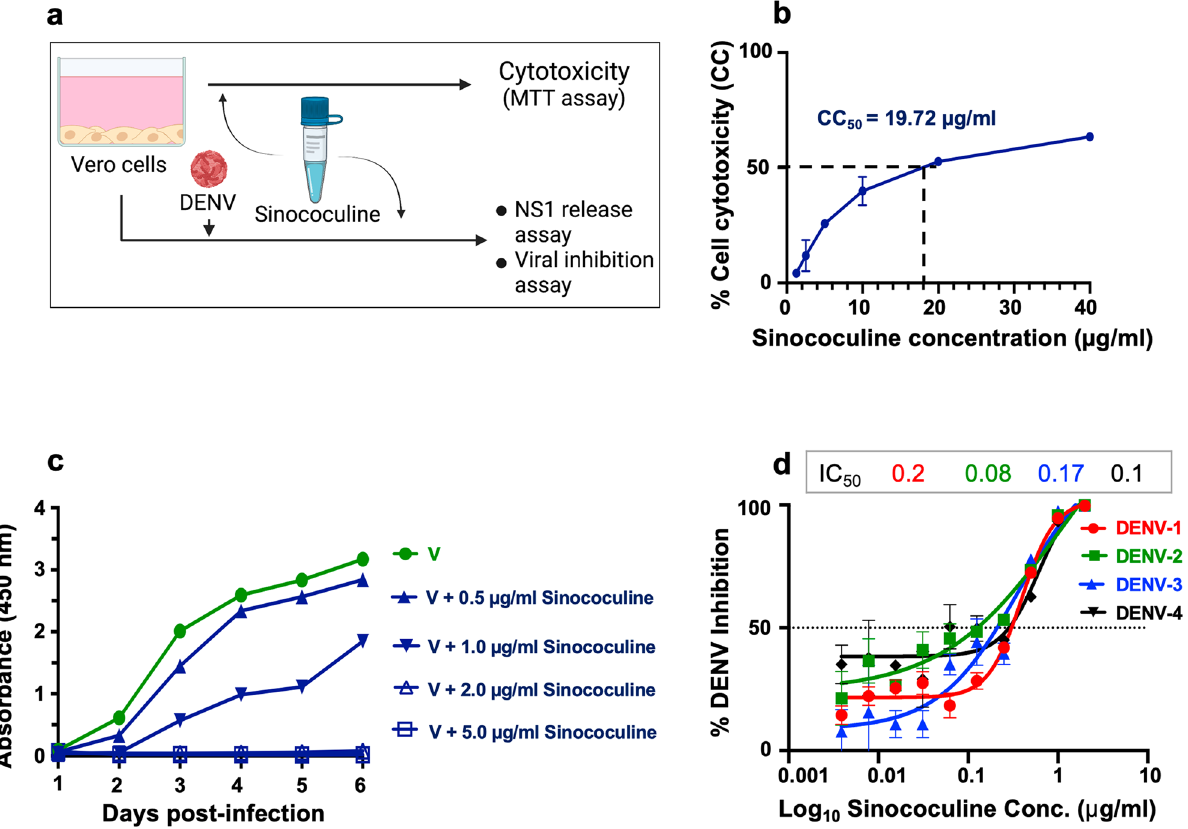
Figure 1. Cytotoxic effect of Sinococuline and inhibition of DENV by Sinococuline treatment. ( a ) Schematic representation of the overall protocol adapted for evaluation of cell cytotoxicity (CC) and DENV inhibition assays. ( b ) Cytotoxicity was evaluated after 48 h post infection by doing MTT assay in Vero cells and plotted the graph using GraphPad prism and the % CC 50 was calculated. ( c ) The DENV antigen NS1 release inhibition was performed, where Vero cells were infected with DENV-2; post infection period, infection media was removed and fresh media was added. Aliquots were collected every 24 h for 6 days and NS1 ELISA was performed. Graph was plotted with days post-infection on X-axis and absorbance unit at 450 nm on Y-axis. ( d ) To calculate the inhibitory concentration of Sinococuline, Flow-cytometry-based virus inhibition assay was performed as reported previously 29 . The % DENV inhibition by Sinococuline treatment with respect to virus control (cells were infected but not treated with Sinococuline) were calculated against all four serotypes and their respective half maximal inhibitory concentration (IC 50 ) was estimated by using Graphpad prism as shown in the table above to the graph. Red, green, blue and black curves represent DENV-1, -2, -3 and -4, respectively. X-axis and Y-axis denote Sinococuline concentrations in their log values and % DENV inhibition,